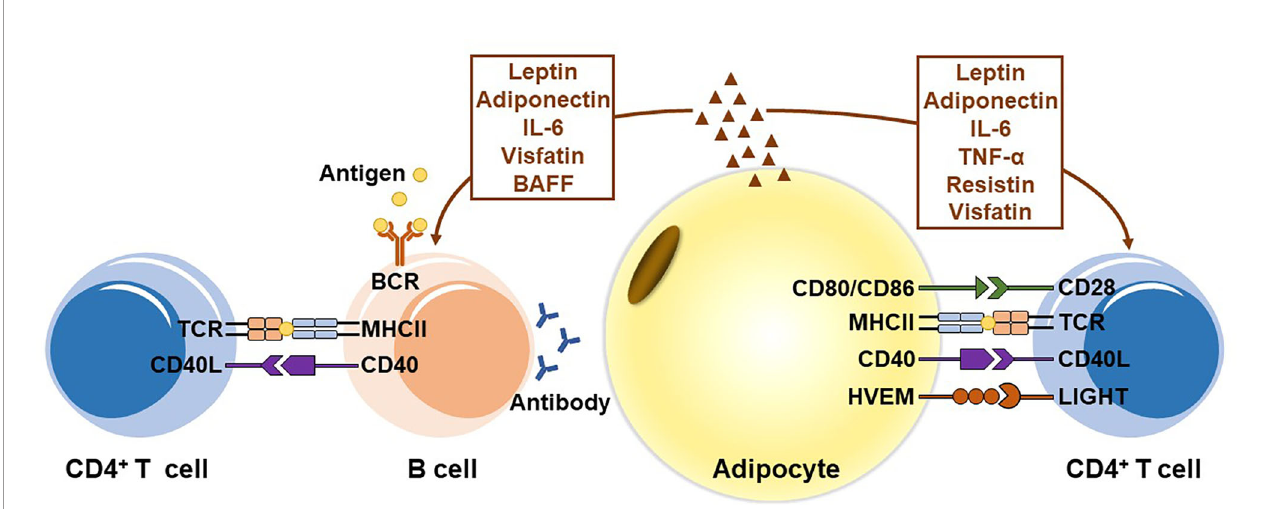
FIGURE 1 | The role of adipocytes in adaptive immunity. Adipocytes express MHC class II molecules and several T cell costimulators to act as antigen-presenting cells (APCs), and induce the activation of CD4 + T cells in visceral adipose tissue during obesity. In addition, adipocytes secrete various adipokines, including leptin, adiponectin, IL-6, TNF- a , resistin, and visfatin, to regulate the proliferation and differentiation of T cells. In B cell-mediated humoral immunity, adipocytes modulate B cell generation, development, aging, activation and antibody production mainly by secreting adipokines, including leptin, adiponectin, IL-6, visfatin, and